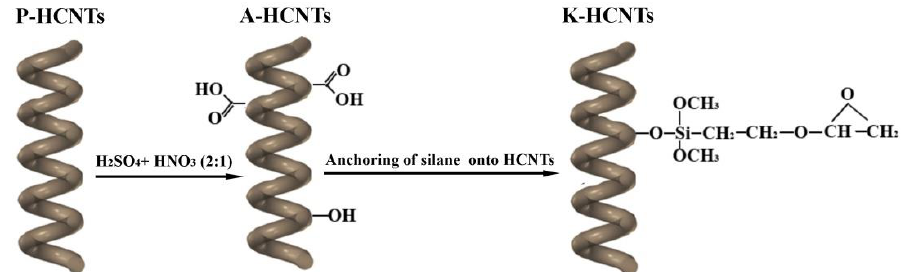
Figure 1. Schematic diagram for the acid oxidation and the silanization treatment of helical carbon nanotubes (HCNTs). Pristine HCNTs (P-HCNTs), acid treated HCNTs (A-HCNTs), and glycidoxypropyltrimethoxysilane (KH560) modified HCNTs (K-HCNTs).